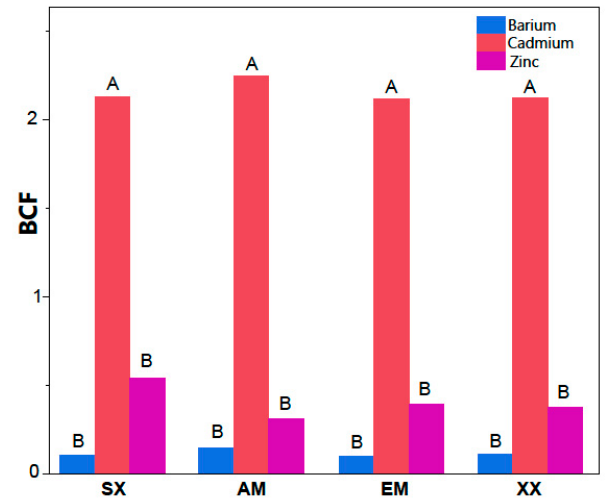
Figure 4. Cd had a significantly higher mean biological concentration factor (BCF) value ( p < 0.0001 ) in each treatment of inoculated Salix miyabeana SX67 ( n = 5) than Ba, or Zn. BCF is calculated here as the ratio of TE concentration in stem tissues to the TE concentration (HNO 3 extractable) in the ground. Columns not sharing a letter are significantly different. AM = AMF inoculation; EM = ECM inoculation; XX = AMF + ECM inoculation; SX = Non-inoculated S. miyabea . Research has shown that willows are more efficient at accumulating Cd and Zn in their aerial parts relatively to other TEs that are preferentially accumulated in the roots such as Pb and Cu [17,35,39–41]. Moreover, edaphic factors, such as humic/fulvic acid content, and pH, increase or decrease the TEs’ bioavailability which influences uptake by plants [42,43]. Here, Ba concentrations were within the expected range for plants (4–50 mg/kg) [44], while Cd and Zn concentrations met and even surpassed the phytotoxic ranges: 5–30 mg/kg for Cd and 100–400 mg/kg for Zn [45]. The